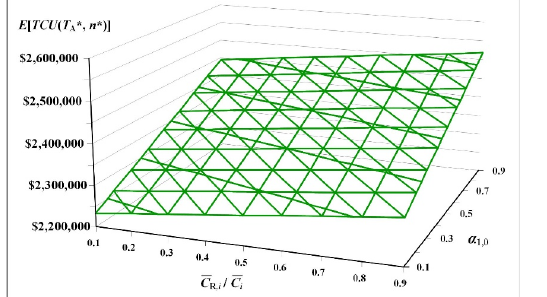
Fig. 8. Joint impact of α 1,0 and γ on t 0 *